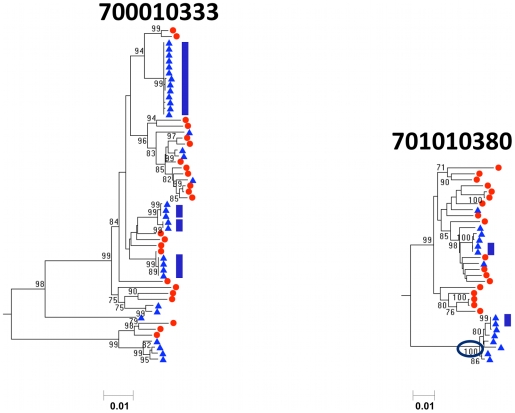
Neighbor-joining tree of SGA-derived env amplicons for two patients with HIV-1 subtype B demonstrating amplification and equilibration in the left panel, and amplification and compartmentalization of seminal sequences in the right panel.Blood SGA-env sequences (red circles) and semen SGA-env sequences (blue triangles). The oval highlights clades of compartmentalized sequences in the semen. Vertical blue bars highlight clonal amplification of specific variants. Bootstrap values ≥70 are shown. An outgroup was included to root the tree but is not shown.